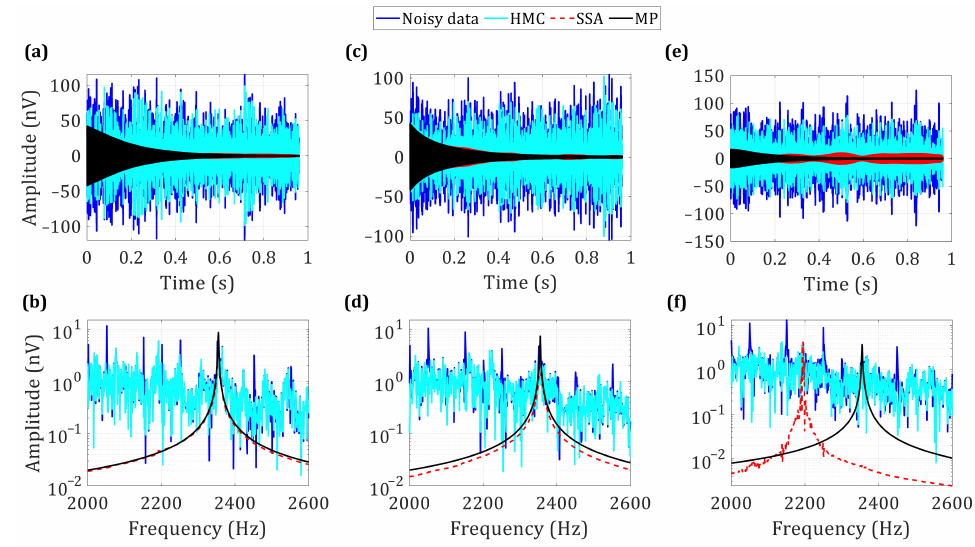
Figure 5. Comparison of the denoising results of the MP, SSA, and HMC algorithms under different SNRs: ( a ) SNR = − 10.7 dB, ( b ) is the corresponding spectrum; ( c ) SNR = − 12.8 dB, ( d ) is the corresponding spectrum; ( e ) SNR = − 14.9 dB, ( f ) is the corresponding spectrum.